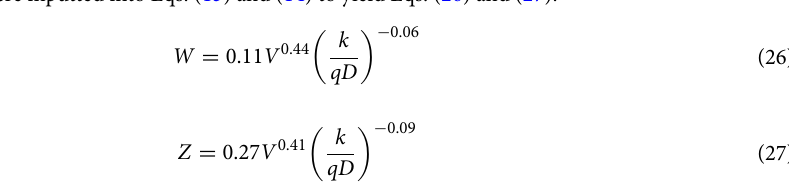
Similarly, from Eqs. (20) and (21), the values for A 1 = 0.11, A 2 = 0.27, b 1 = 0.44, and b 2 = 0.41, respectively, we obtained, and these were inputted into Eqs. (13) and (14) to yield Eqs. (26) and (27).